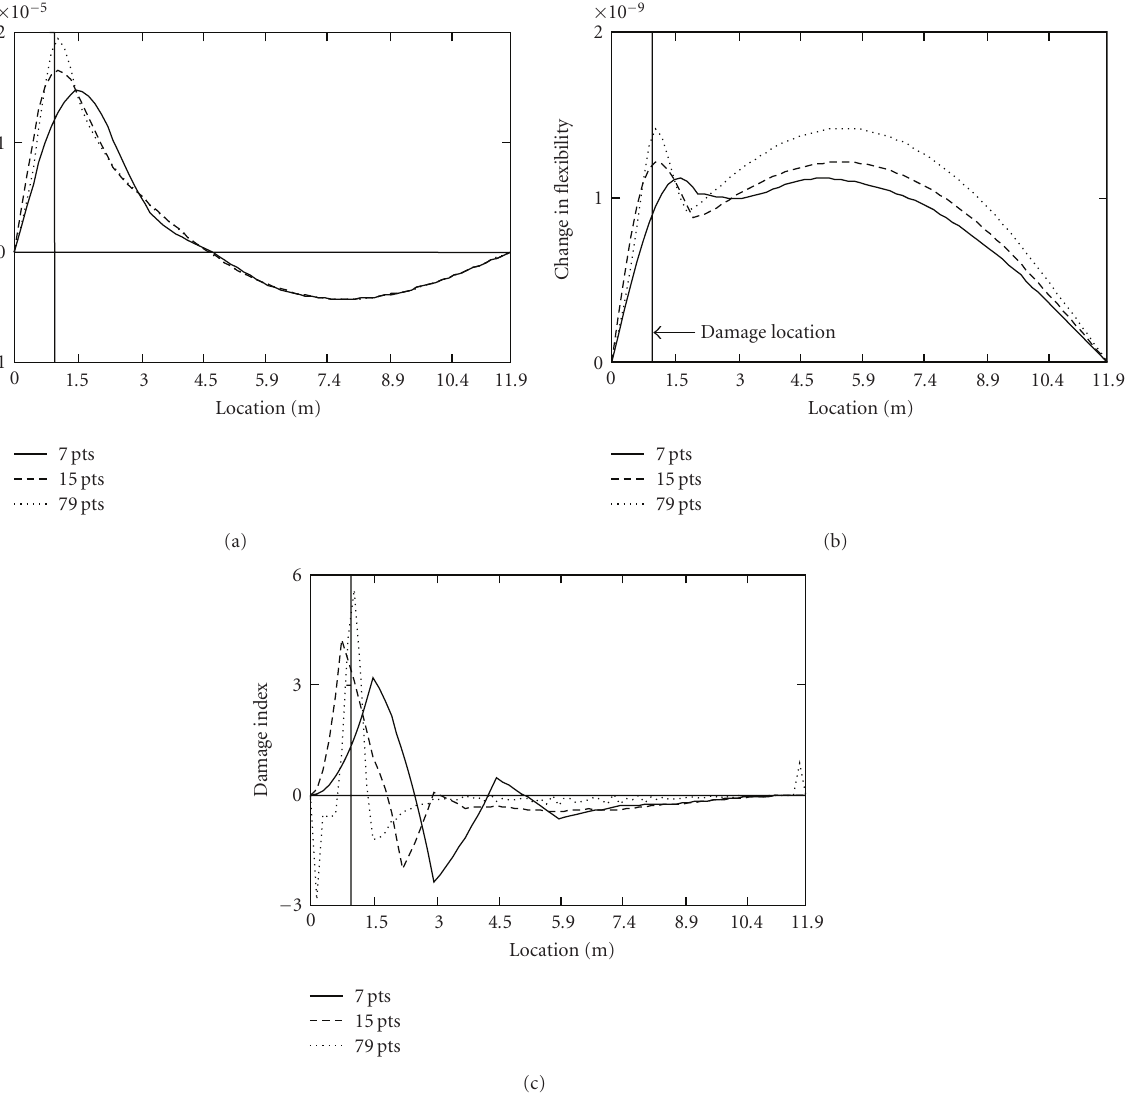
Figure 11: Comparison of VBDD parameter distributions for numerical damage case 7, obtained using 7, 15, and 79 measurement points for (a) the CMS, (b) MCF, and (c) DI methods. Labels along the location axis correspond to the seven measurement